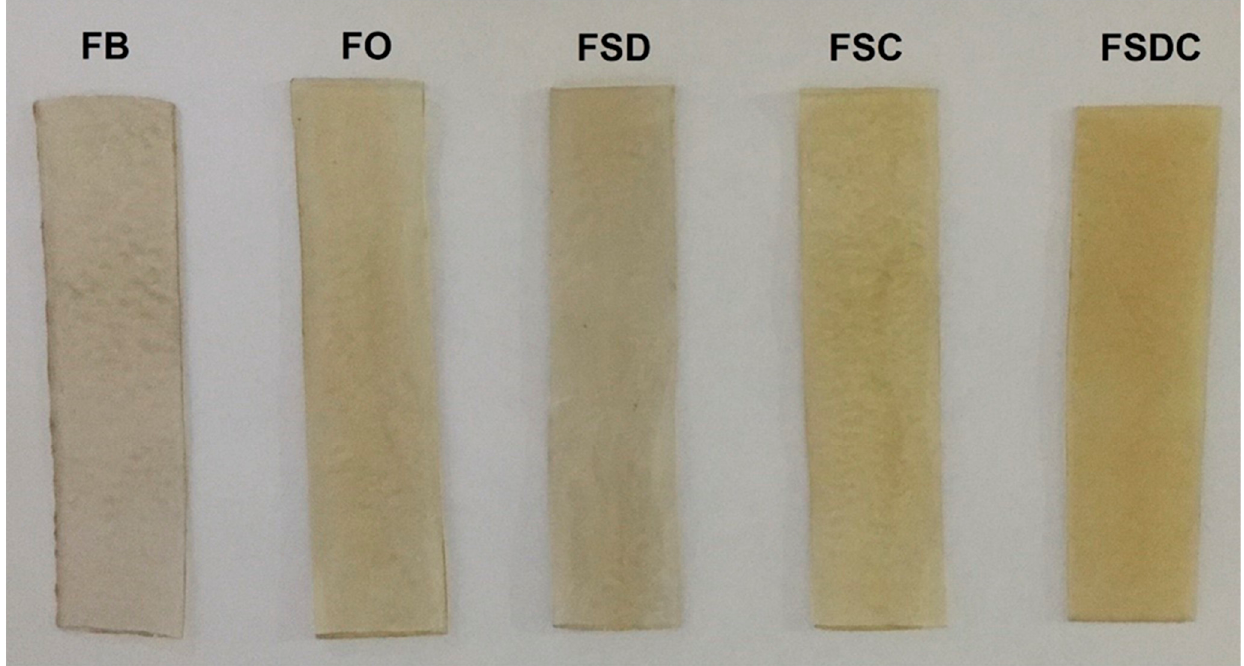
Figure 1. Visual aspect of cassava starch sheets enriched or not (FB) with tucumã oil (FO) and tucumã oil microparticles (FSD, FSC and FSDC) obtained by different encapsulation methods.